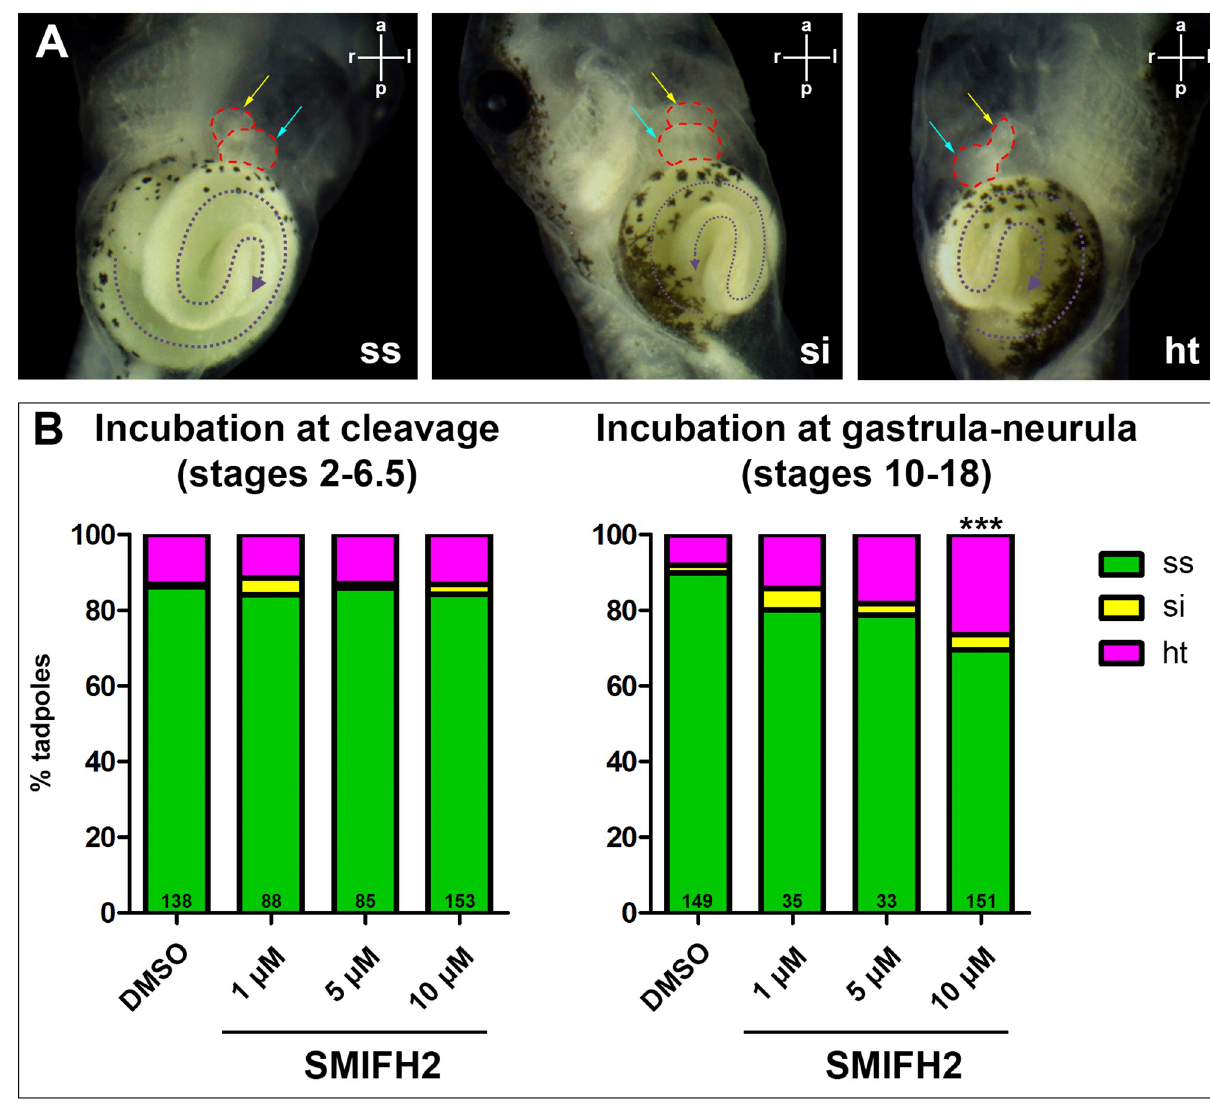
Fig 2. Visceral organ situs after formin inhibition. (A) Representative images of formin-modulated stage 46 tadpoles displaying normal organ situs (ss), situs inversion (si), or heterotaxia (ht), as determined by the direction of heart looping (outlined by dashed red line) and gut coiling (outlined by dashed violet line), ventral view. (B) Formin inhibitor SMIFH2 had no effect on organ situs in the tadpoles treated during cleavage (N = 5) and reduced the proportion of tadpoles with normal organ laterality after treatment with 10 μ M SMIFH2 during gastrulation and neurulation (N = 5). a, anterior; ht, heterotaxia; l, left; p, posterior; r, right; si, situs inversus; ss, situs solitus. Cyan arrows indicate heart ventricle, yellow arrows indicate truncus arteriosus. ��� , p-value = 0,00006552 compared with the DMSO control, two-proportions z-test with Bonferroni correction; N, number of experiments. Numbers at the base of columns represent number of analyzed